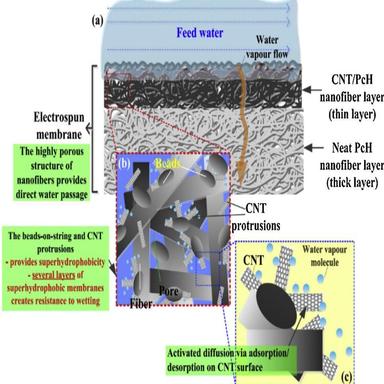
Schematic presentation of the working mechanism of CNT/PH nanofiber membrane for MD application .